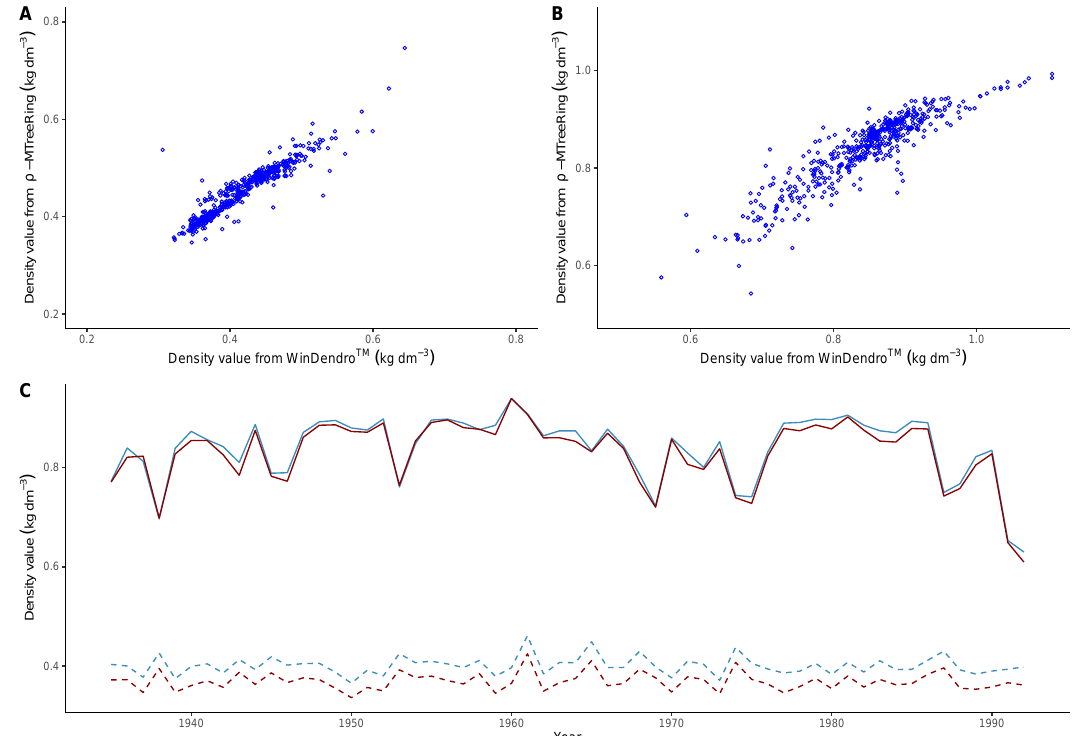
Figure 3. Comparative results of WinDENDRO™ and ρ -MtreeRing. ( A ) Value comparison for minimum density ( r = 0.962) and ( B ) for maximum density ( r = 0.966). ( C ) Comparison of maximum (solid line) and minimum (dashed line) density values extracted from one of the measured series using WinDENDRO™ (red) and ρ -MtreeRing (blue) with a path of 8-pixel